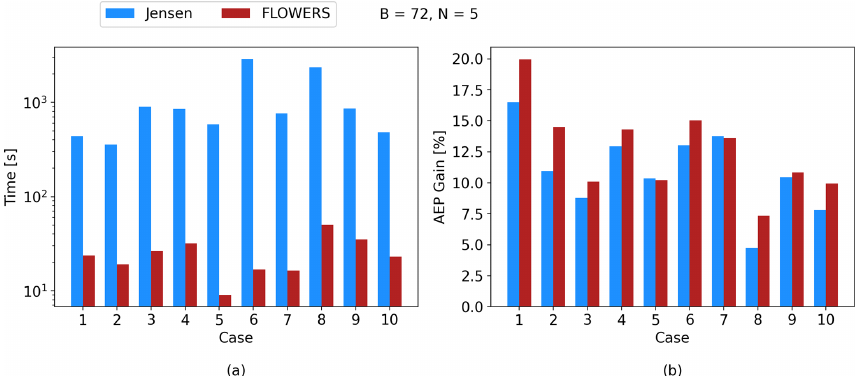
Figure 10. A comparison of cost and performance for 10 cases with randomized initial conditions. Five Fourier modes are used for the FLOWERS solution, and 72 wind direction bins are used for the Jensen numerical integration. FLOWERS is on average about 48 times faster than Jensen and achieves an AEP gain that is 1.5%